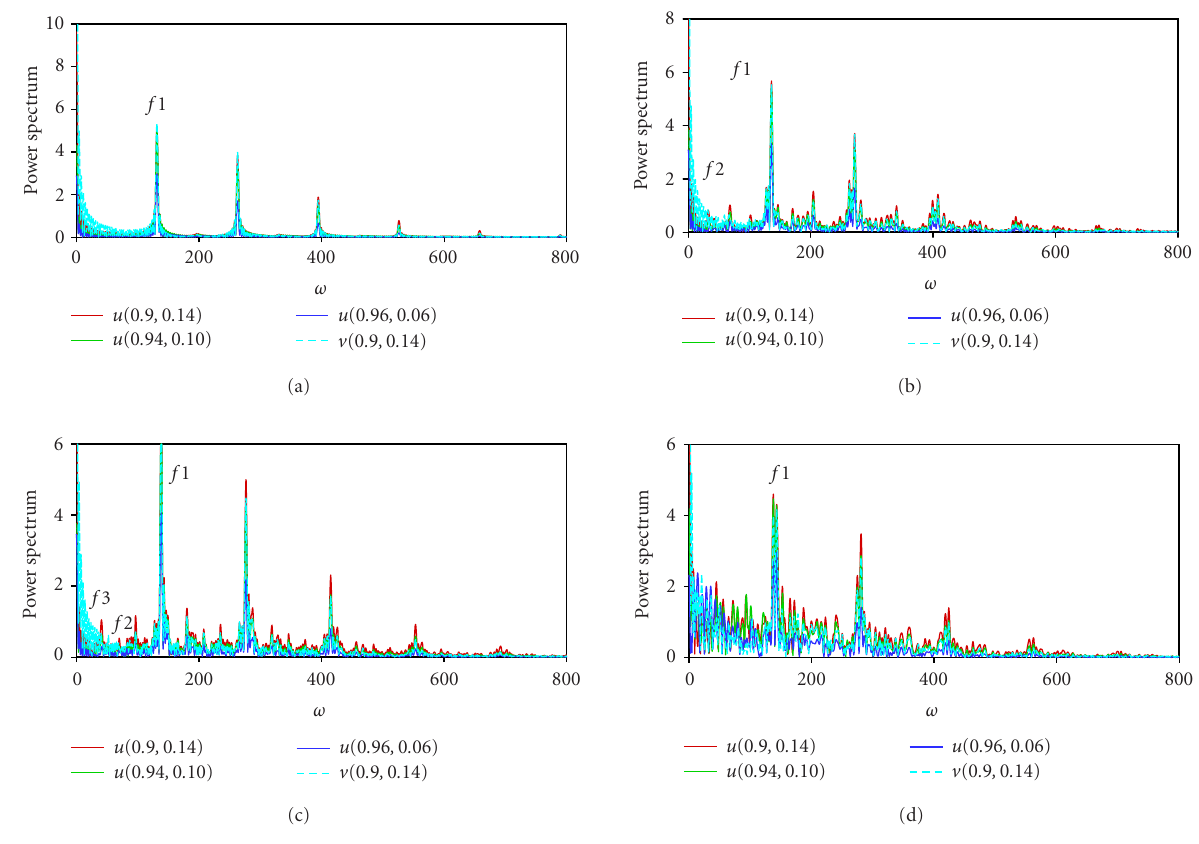
Figure 12: Power spectra of temporal series shown in Figure 11 ( σ = 0 . 02, Pr = 0 . 7, Dk = 300, and L 1 = 28); (a) L 2 = − 10 . 20 on AS 1 s , (b) L 2 = − 10 . 25 on AS 1 s , (c) L 2 = − 10 . 30 on AS 1 s , and (d) L 2 = − 10 . 35 on AS 1 s .